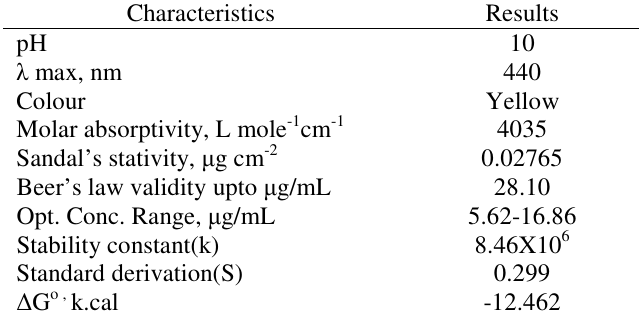
Table 1. Physicochemical and analytical characteristic of Cd(II)-HBBrPT.